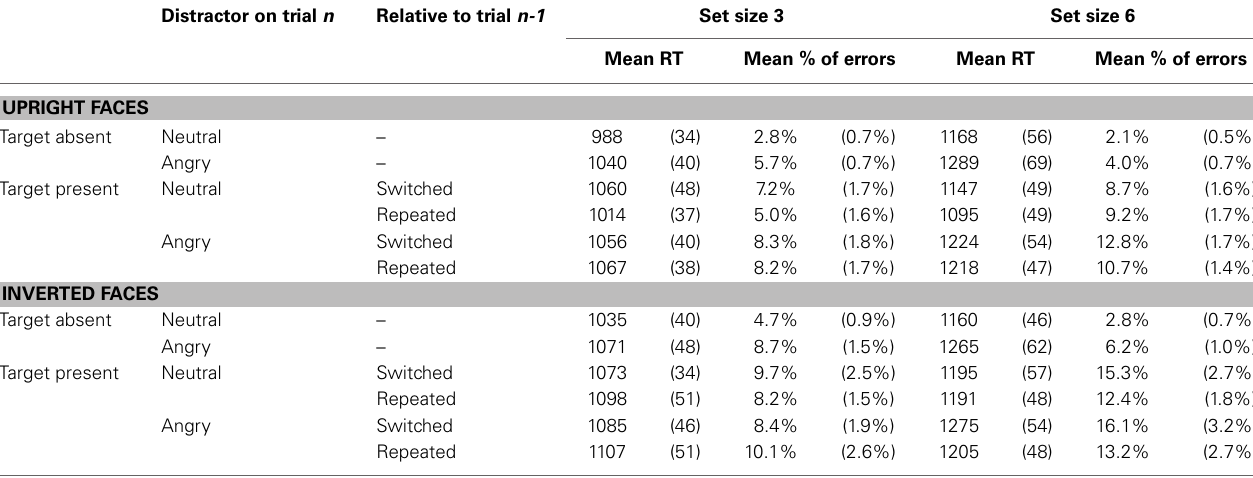
Table 1 | Mean reaction times (in milliseconds) and percentage of errors by conditions of target presence (present vs. absent), distractor on trial n (angry vs. neutral), feature repetition relative to trial n-1 (repeated vs. switched) and set size (3 vs. 6) in Experiment 1, separately for upright faces and for inverted